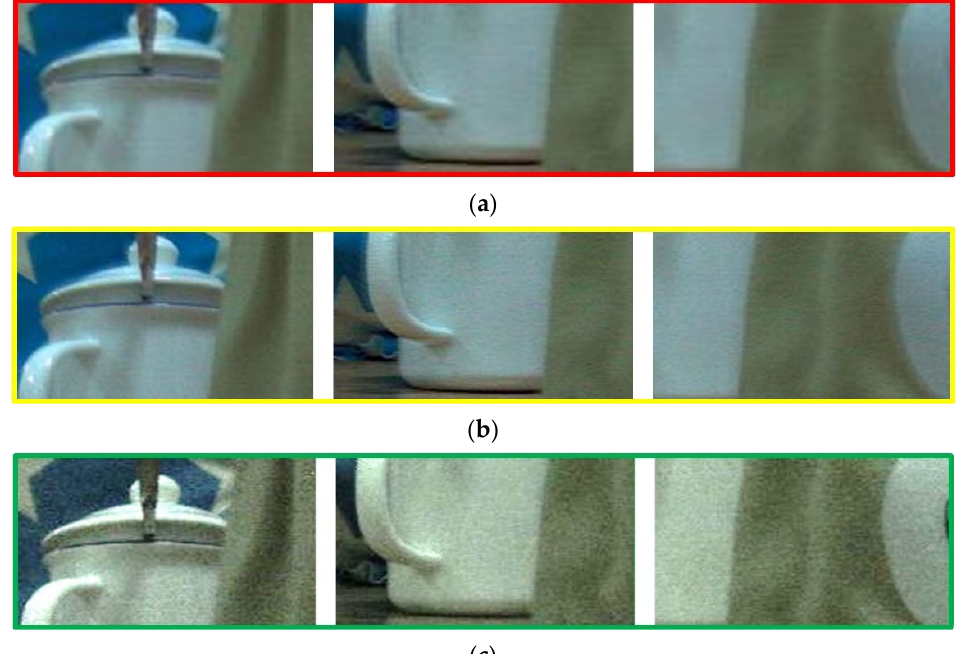
Figure 10. Comparative result images. ( a ) Extracted view angle image based on the proposed aperiodicity method with the proposed LC microlens; ( b ) the corresponding weighted average result images of ( a ); ( c ) extracted view angle image based on the conventional periodicity method with the conventional LC microlens. To present much more details, those images have been magnified to a certain